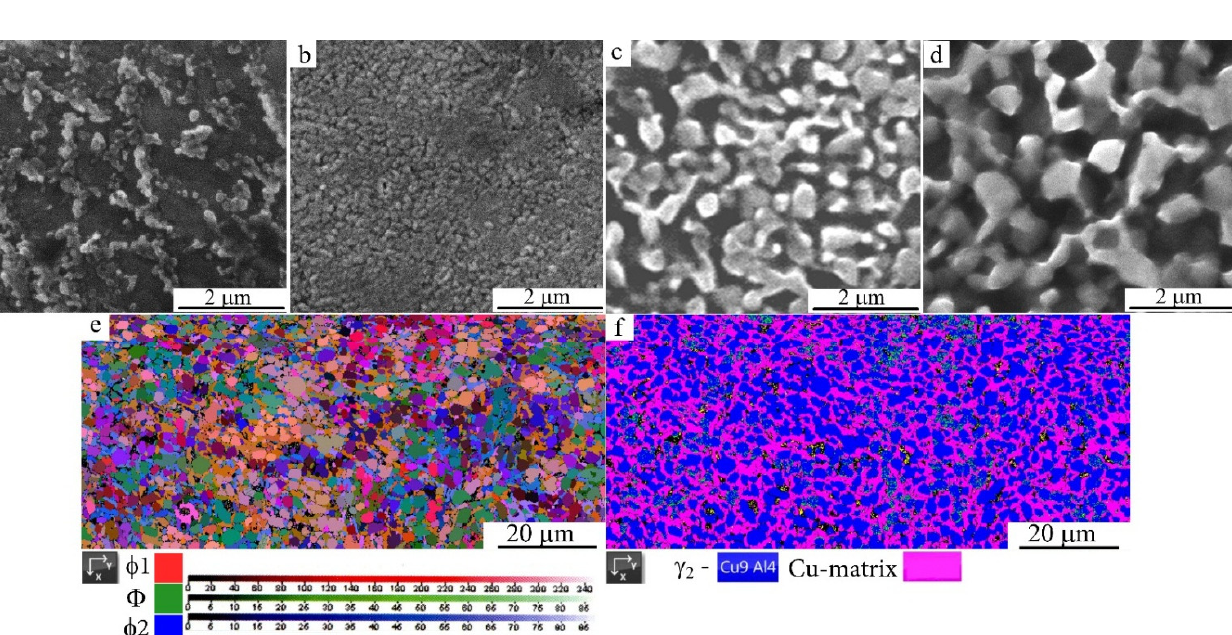
Figure 30. ( a – d ) Bright-field TEM images of microstructure and ( a ’– d ’) corresponding SAED pat- terns of the Cu-14Al-3Ni alloy after the HPT of 10 revs and isochronous anneals (for 30 min) at temperatures of: (a,a’) 573 K, (b,b’) 673 K, (c,c’) 773 K, and (d,d’) 873 K [46].